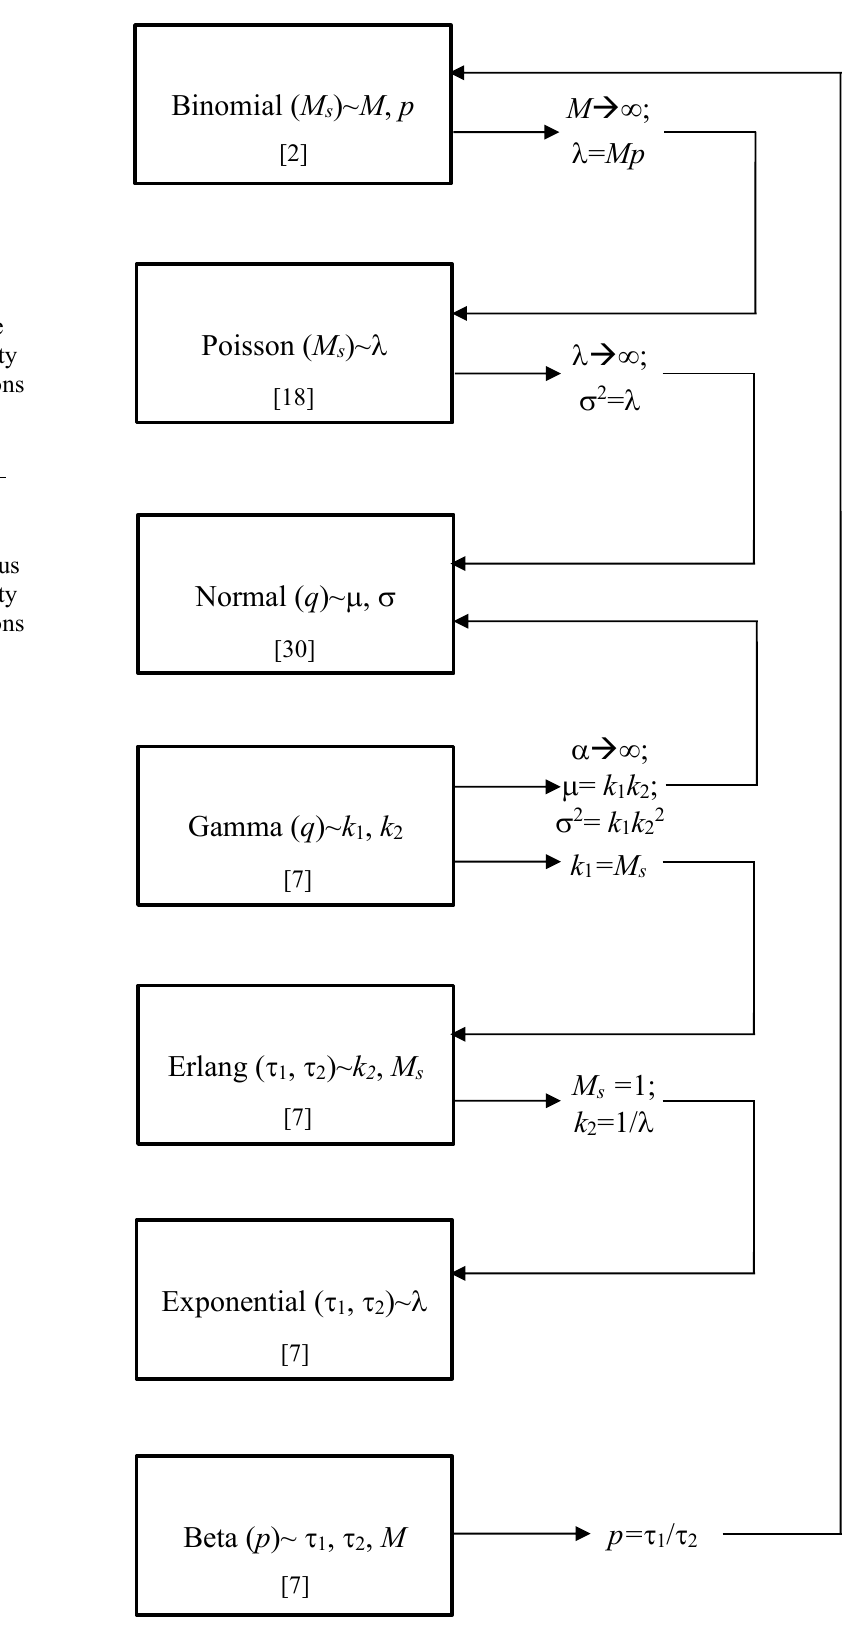
Figure 2. Parametric demand model.